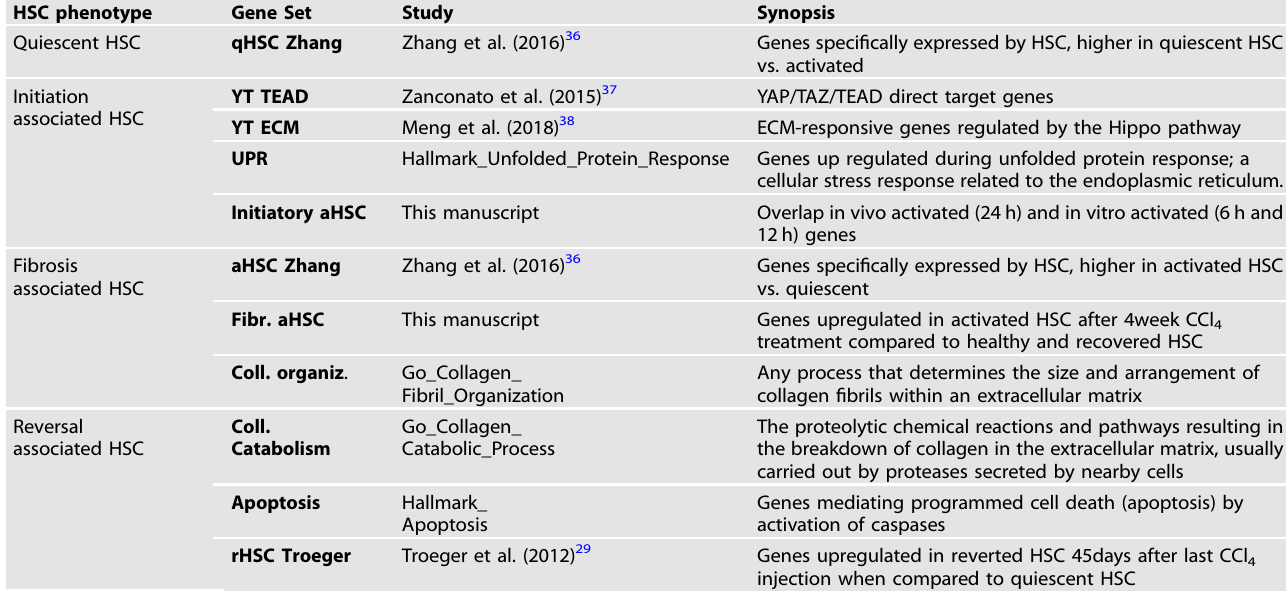
Table 1. Selected gene sets correlating with HSC phenotypes and their functional